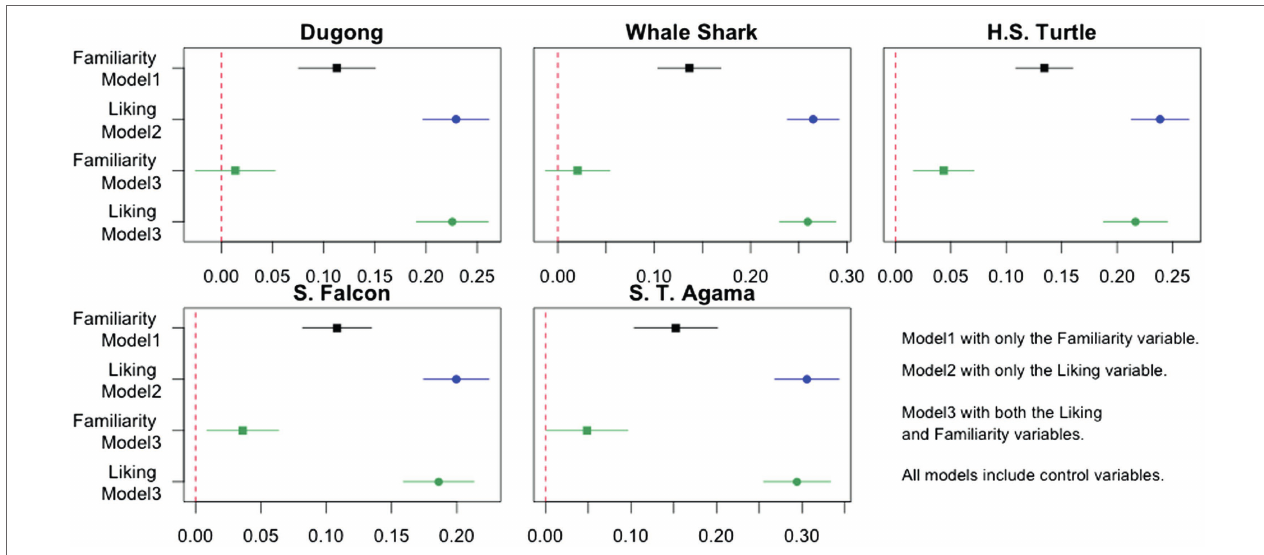
FIGURE 3 | Ordinary least squares coefficients and 95% confidence intervals: Comparing the effects of familiarity and liking on the endorsement of government